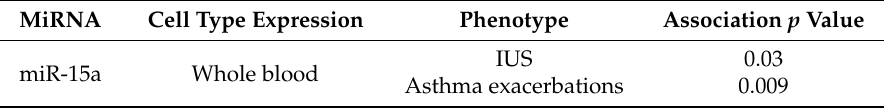
Table 6. Association of miRNA with IUS and asthma severity in Asthma